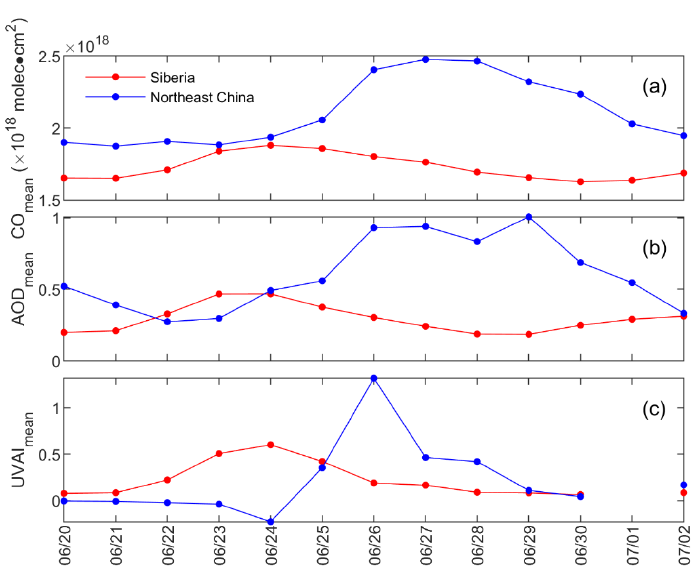
Figure 6. Daily mean values of ( a ) CO column concentration, ( b ) AOD, and ( c ) UVAI in Siberia and Northeast China.